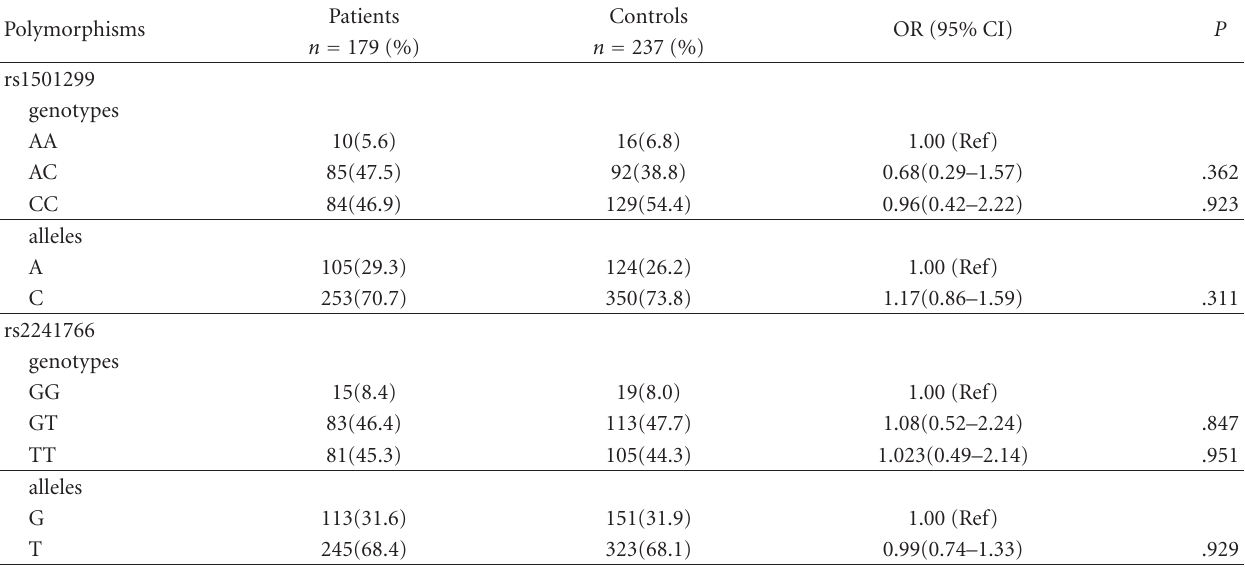
Table 2: Genotype and allele frequencies of rs2241766 and rs1501299 in ADIPOQ between patients with asthma and controls.